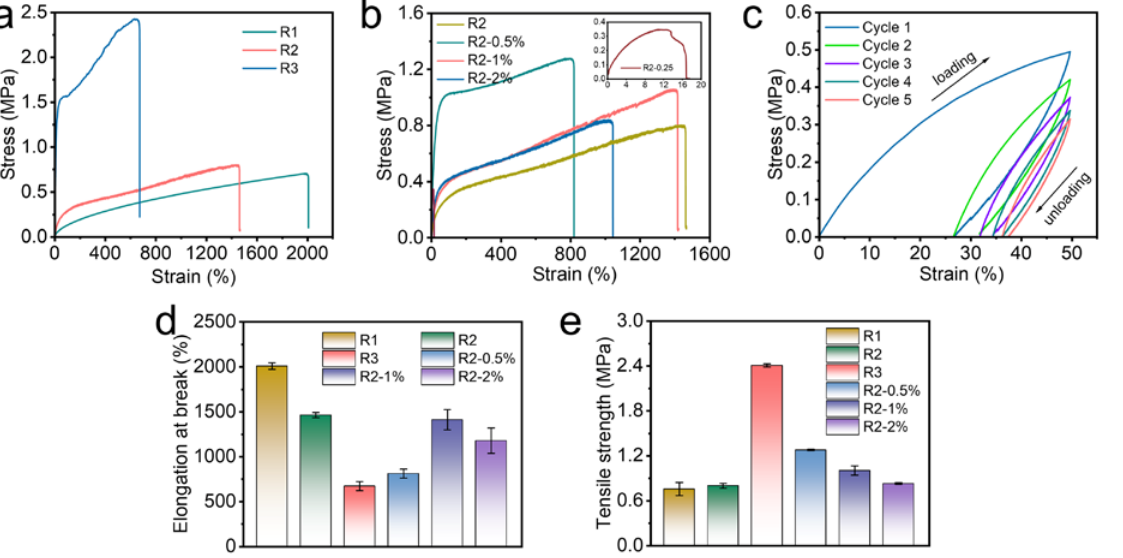
Figure 5. Mechanical properties of the samples. ( a , b ) Stress–strain curves for samples. ( c ) Continuous cyclic tensile loading–unloading curves at 50% strain without resting time between each cycle. ( d , e ) Elongation at break and Tensile strength of the